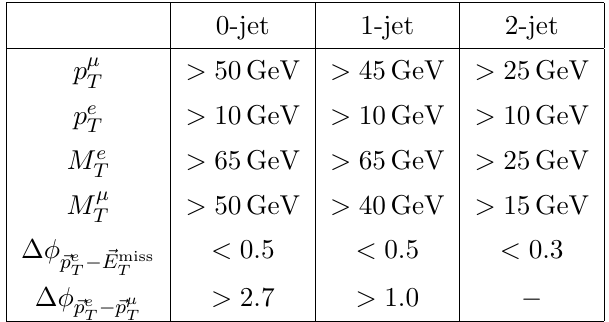
Table 1. Selection criteria for each categories jet categories. The transverse mass M ‘ as M ‘ = T